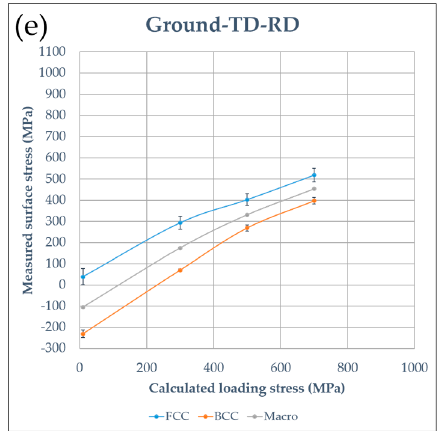
Figure 5. In-situ measured surface stresses along loading direction under four-point bend loading of: ( a ) AD-RD specimen; ( b ) AD-TD specimen; ( c ) Ground-RD-RD specimen; ( d ) Ground-RD-TD specimen; and ( e ) Ground-TD-RD specimen. Positive values denote tensile stresses and negative compressive stresses.